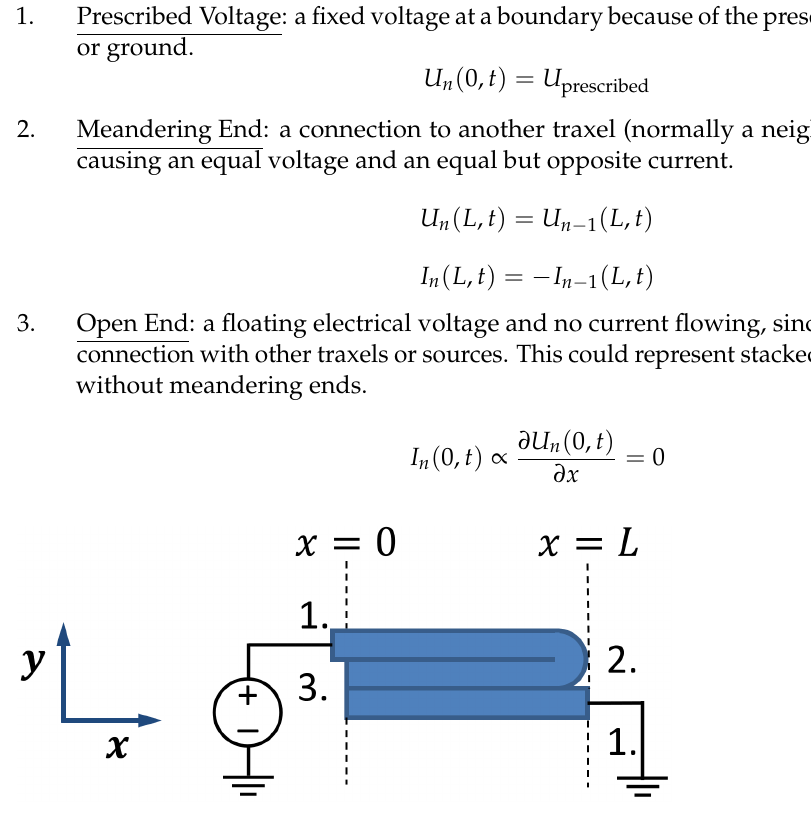
Figure 5. The possible boundary conditions for traxels: 1. Prescribed Voltage, 2. Meandering End, and 3. Open End.